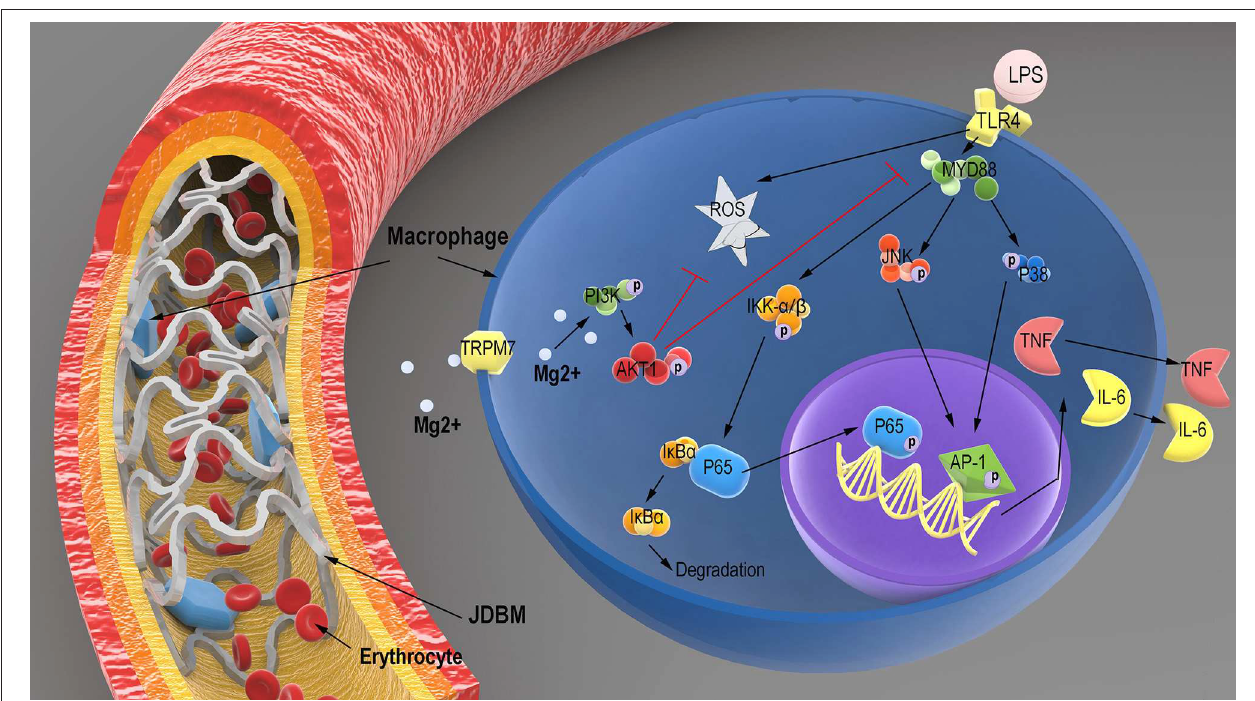
FIGURE 10 | Schematic illustration of the potential regulatory mechanism of LPS-induced inflammatory responses in macrophages treated with the degradation products of JDBM. After JDBM cardiovascular stent was implanted, macrophages would adhere to the surface of stent owing to the FBR. The magnesium from the degradation products of the JDBM passed into the cytoplasm of macrophages through the TRPM7 channel to activate the PI3K–AKT1 signaling pathway and scavenged intracellular ROS to prevent the inflammatory response based on the LPS-induced activation of the TLR-4–MYD88–NF- κ B/MAPK signaling pathway, which show good anti-inflammatory effects of Mg-based alloy. LPS, lipopolysaccharide; JDBM, Mg–Nd–Zn–Zr alloy; FBR, foreign body response; ROS, reactive oxygen